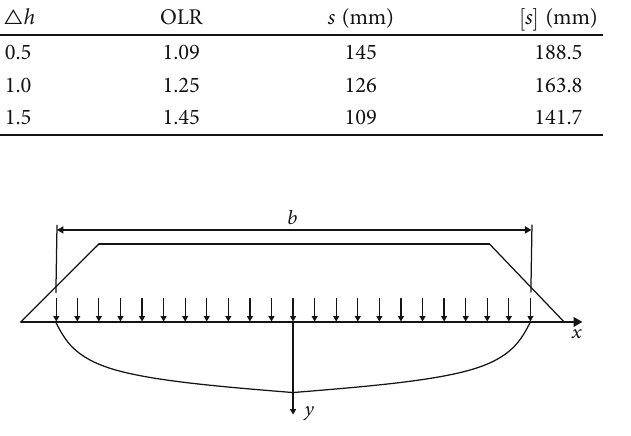
Figure 12: Settlement curve of cross-section of embankment.